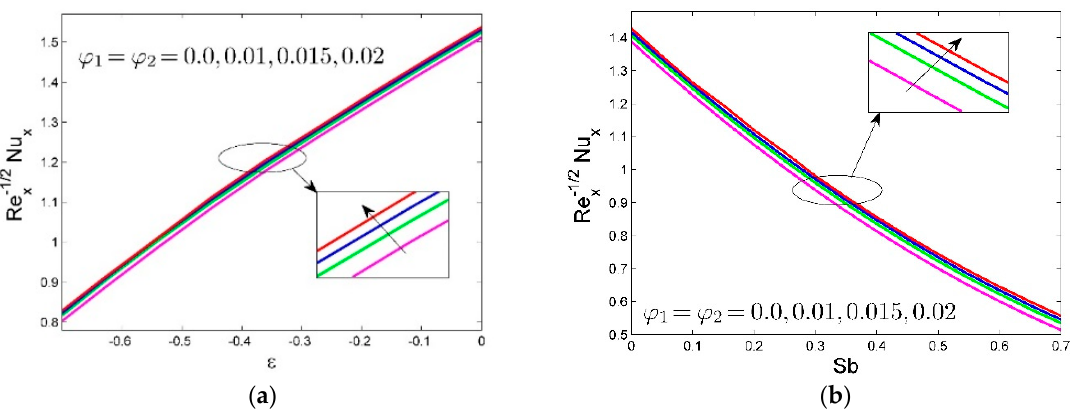
Figure 9. Impacts of 𝜑 (cid:2869) and 𝜑 (cid:2870) against ε and Sb on Nu . ambient concentration to surface concentration (see Figure 10b).